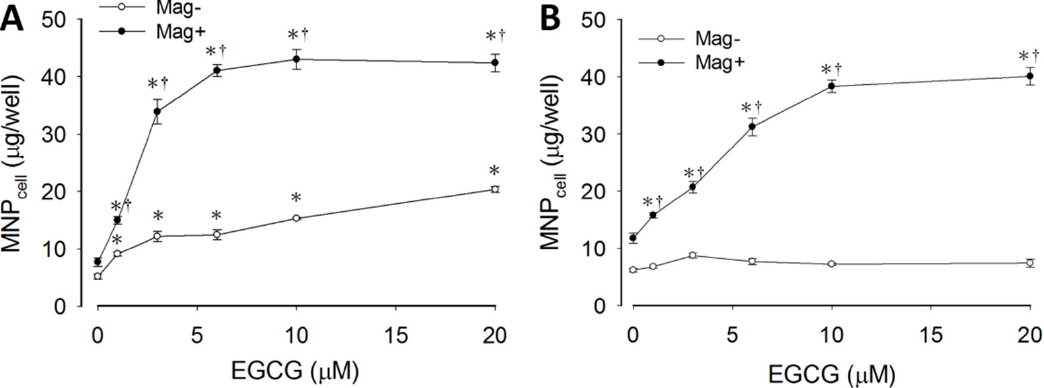
Figure 1. EGCG-enhanced uptake of MNPs by tumor cells. LN-229 ( A ) and A431 ( B ) cells were incubated with CMX-MNPs (50 µ g/well) in the absence (Mag − ) or presence (Mag+) of the magnet for 2 h prior to determination of cell-associated MNPs (MNP cell ). Values are mean ± SEM ( n = 4). * , † p < 0.05 compared with corresponding group without EGCG or magnet, respectively.